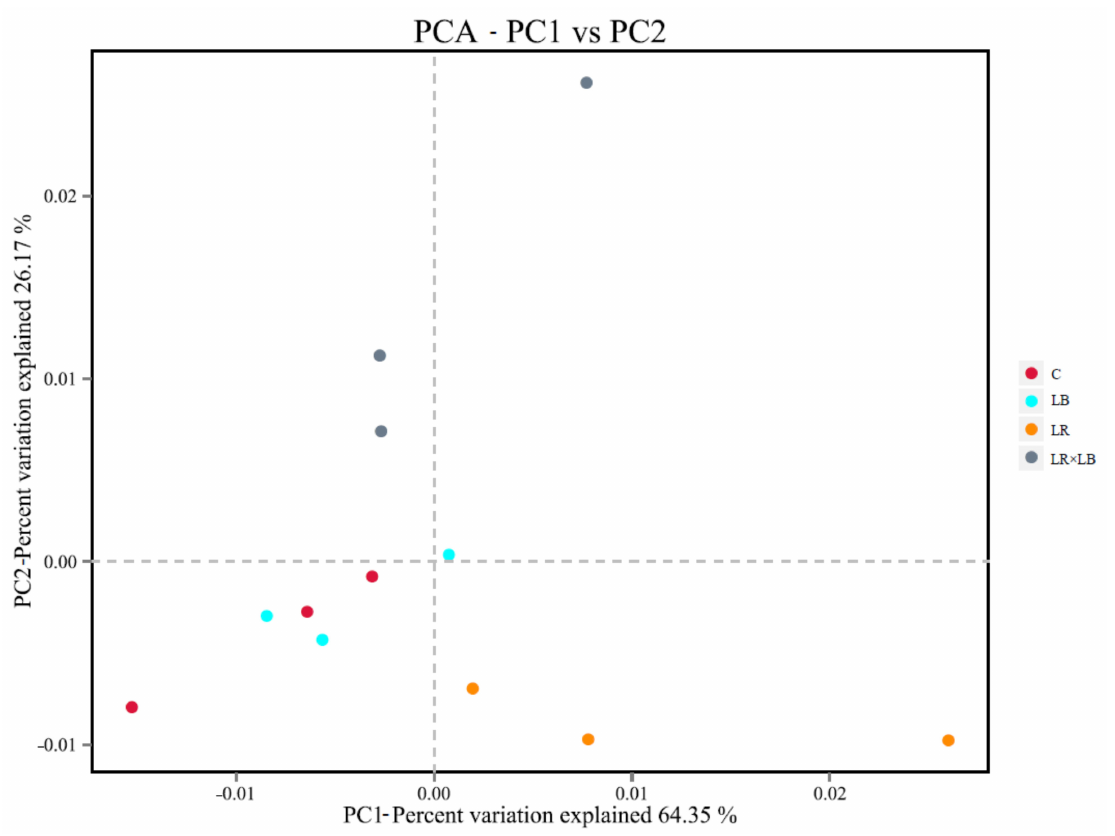
Figure 4. Principal component analysis (PCA) graph of the bacterial community succession between studied samples of paper mulberry silage. C: silage with distilled water; LB: silage with LB-TSy; LR: silage with LR-BDy; LR × LB: silage with LB-TSy and